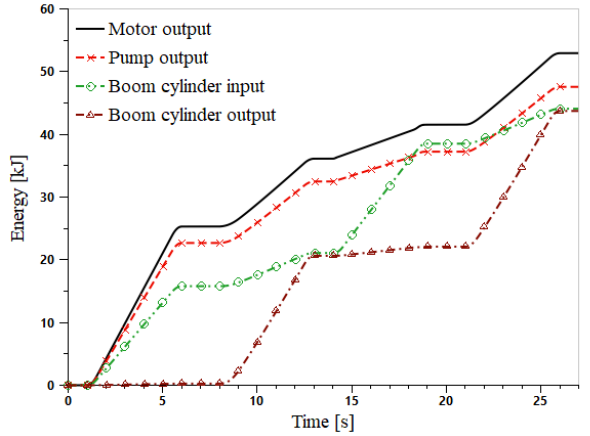
Figure 14. Energy consumption of the proposed system with an empty bucket.